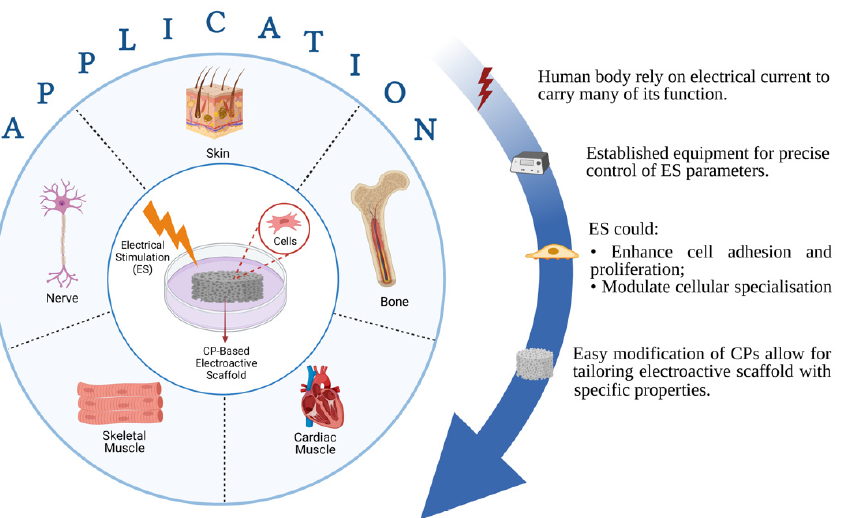
Figure 1. Illustration about advantages of conductive polymeric (CP)-based electroactive scaffold and their electrical stimulation for various tissue engineering applications.